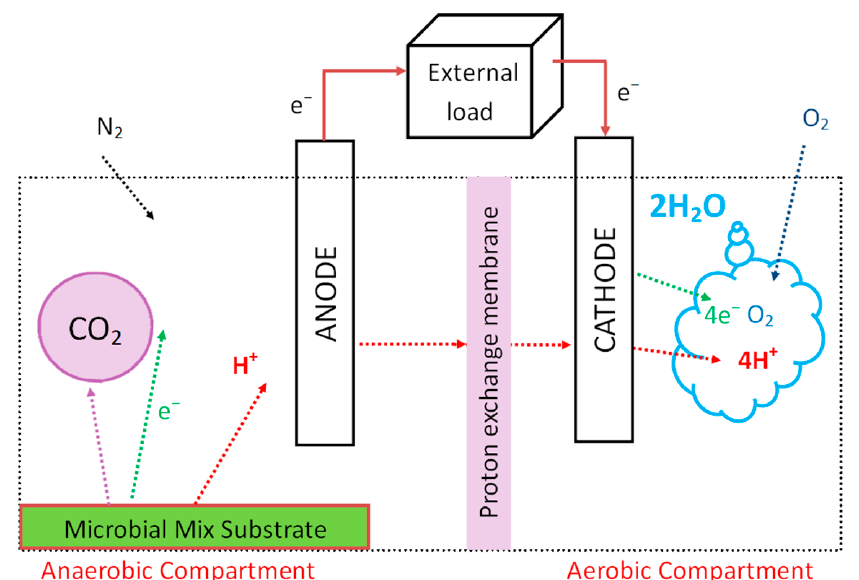
Figure 2. Scheme of the microbial fuel cell. The electrodes are connected by a wire and electrons from the redox reactions in the anode compartment are passed through the wire to the cathode. As the microbial mix substrate is providing protons in the anaerobic chamber to transfer to the aerobic one, the electrical circuit is complete, and the charge is generated.